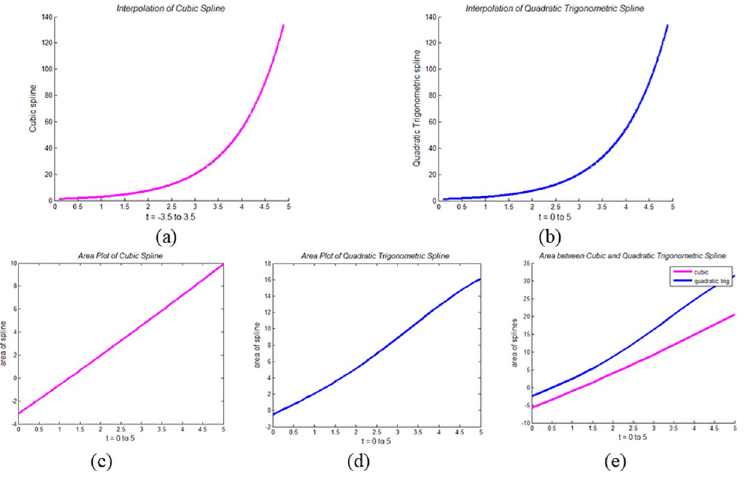
Fig 7. Area Analysis of QTS and CPS using f = e t : (a) Plot of CPS, (b) Plot of QTS, (c) Area plot of CPS, (d) Area plot of QTS, and (e) Area between CPS and